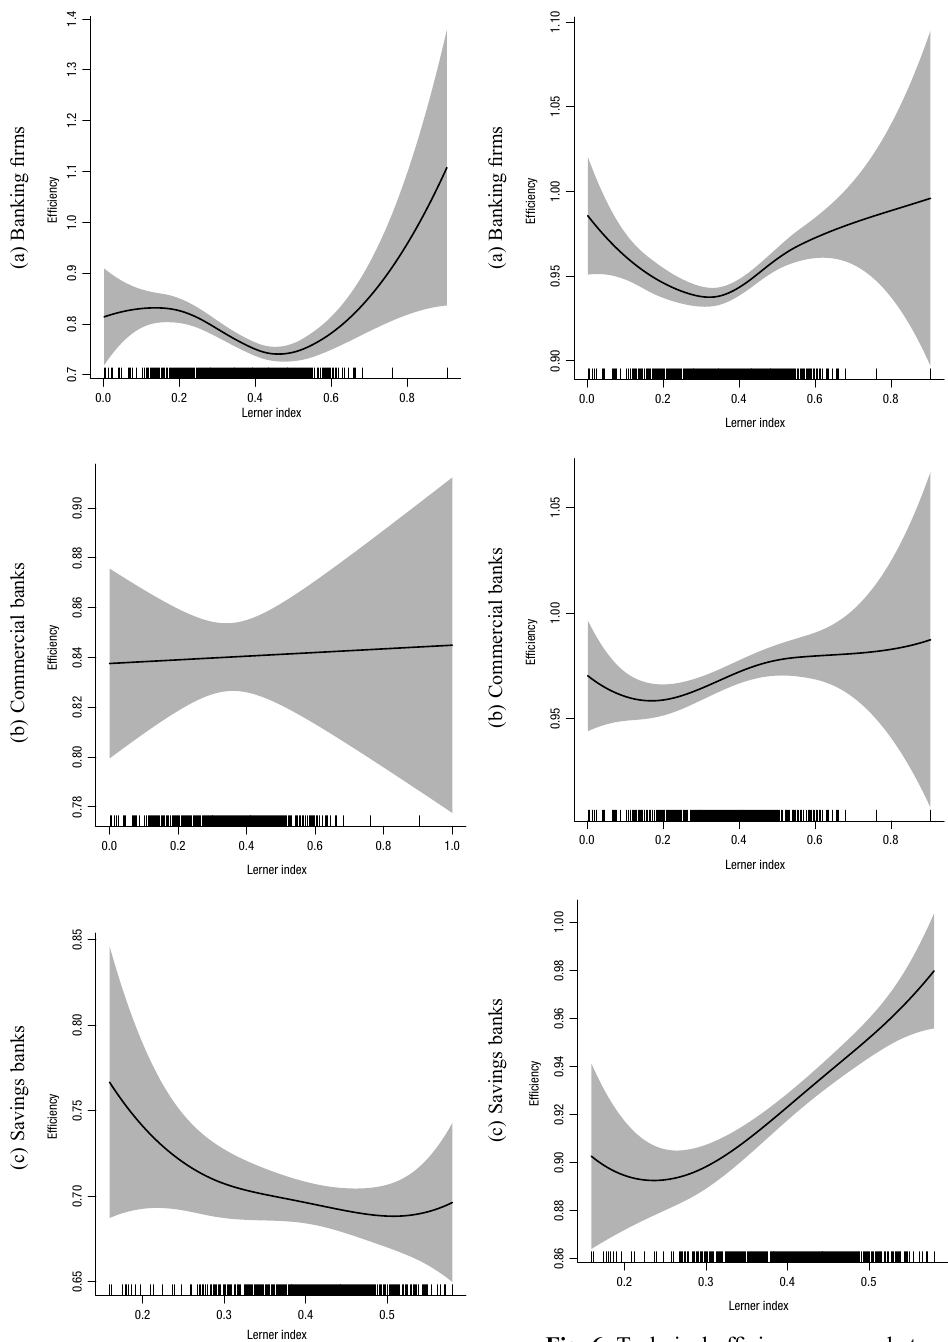
Fig. 6. Technical efficiency vs. market power (Lerner index), spline smoothing regression,